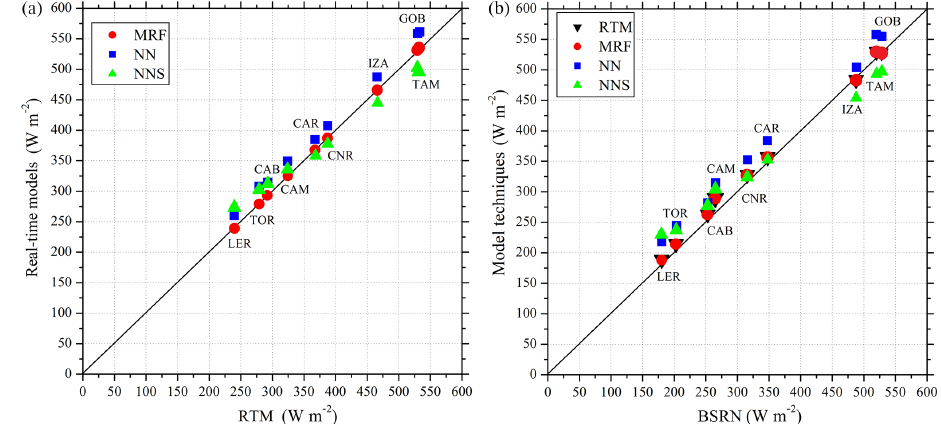
Figure 5. The mean GHI in Wm − 2 of the real-time modelling techniques as compared to the RTM simulations for all ground stations (a) , and the mean GHI of all models as compared to the BSRN measurements (b) .